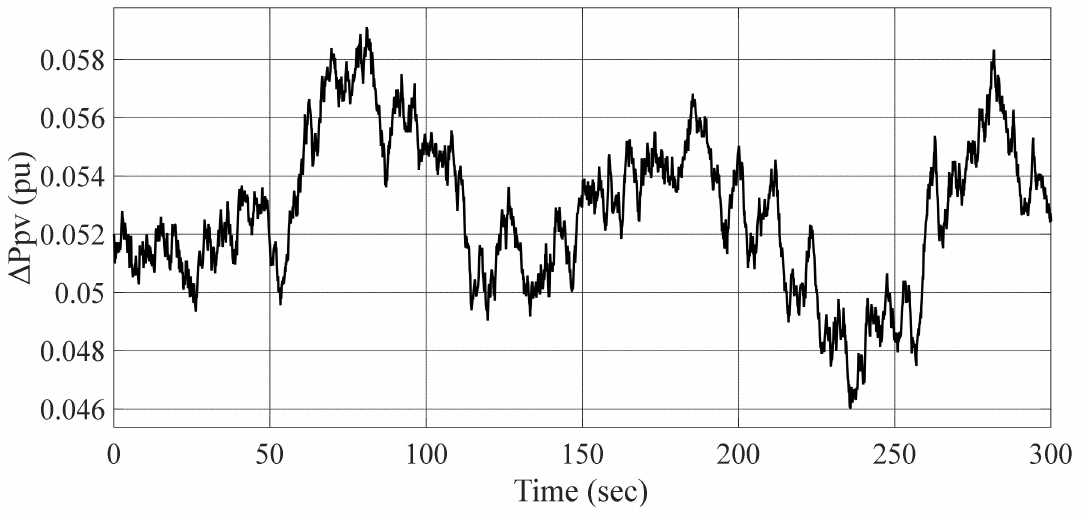
Figure 6. The output power of the photovoltaic